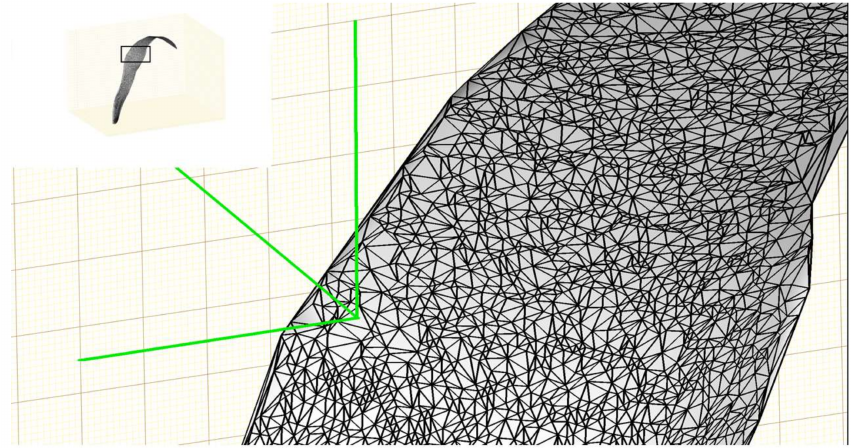
Figure 4. Example of triangulation of a fitted leaf surface in order to calculate leaf area, leaf inclination angle, and leaf angular